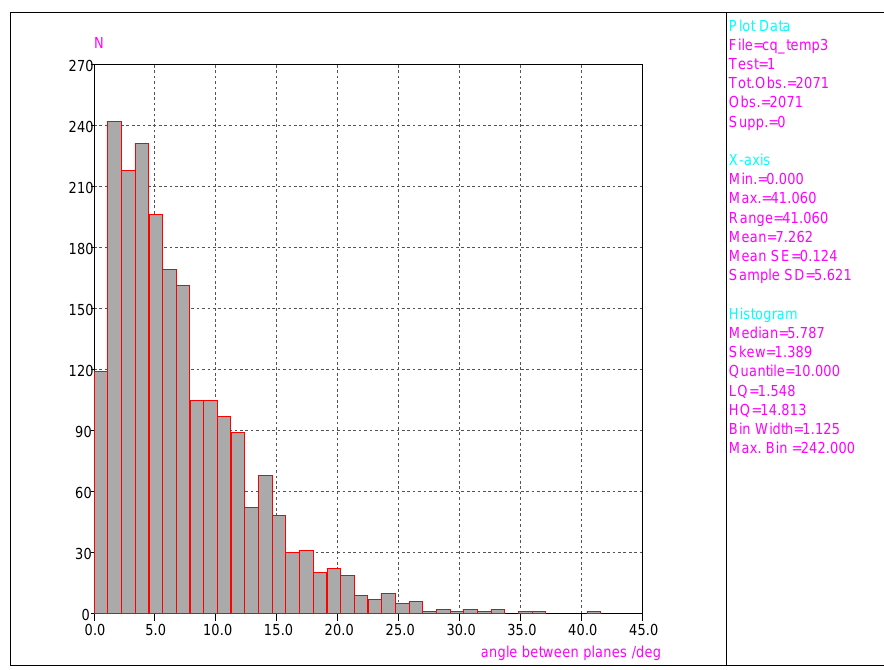
Figure 4. Distribution of the twist angle between NO 2 and phenyl ring planes for para -substituted nitrobenzene derivatives.